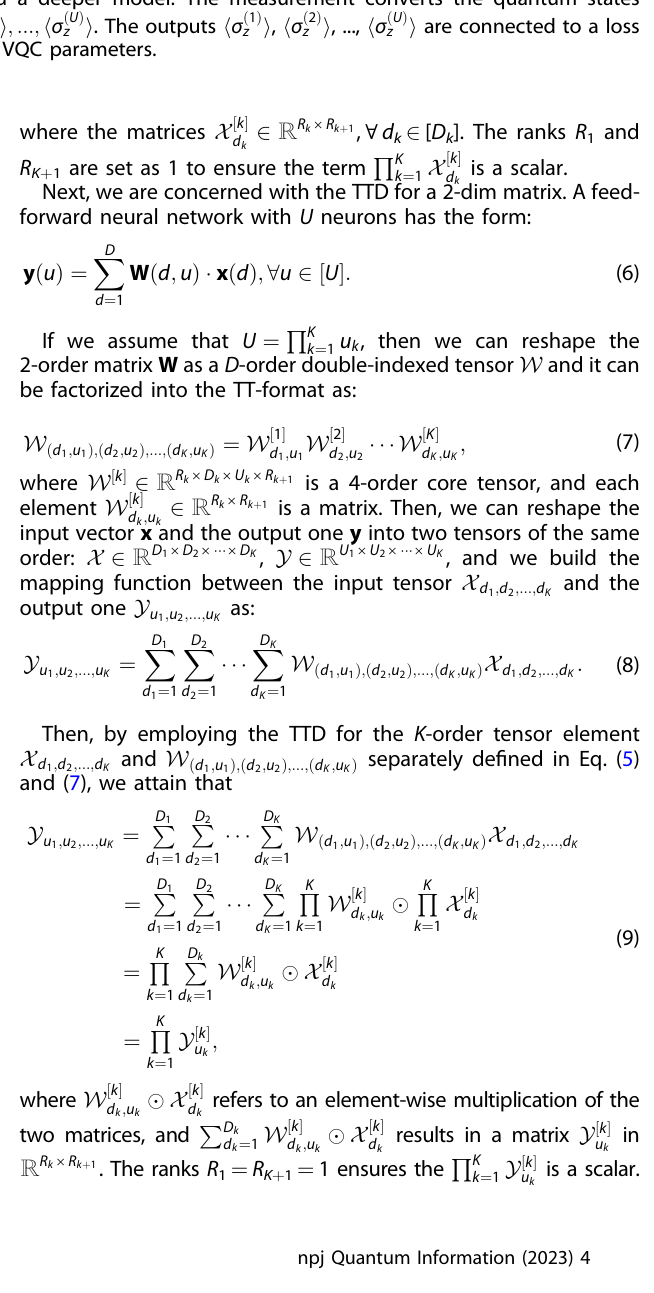
Fig. 2 An illustration of three components in the VQC model. The TPE employs a series of R Y ð π states. The PQC is composed of CNOT gates and single-qubit rotation gates R X , R Y , R Z with free model parameters α , β , and γ . The CNOT gates impose the operation of quantum entanglement among qubits, and the gates R X , R Y , and R Z can be adjustable during the training stage. The PQC model in the green dash square is repeatably copied to build a deeper model. The measurement converts the quantum